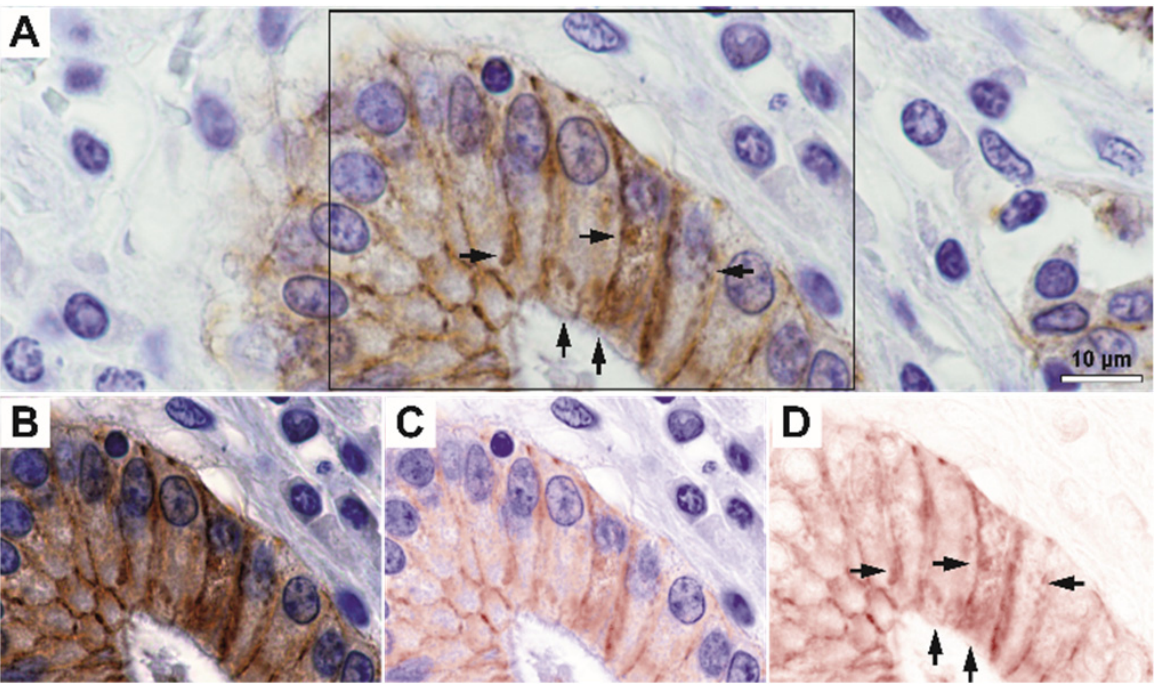
Figure 2. Exemplary image of control gastric glandular epithelium stained for E-cadherin. ( A ) RGB image and ( B – D ) unmixed individual and merged images showing membrane and intracytoplasmic staining (arrows). The rectangle in Figure ( A ) represents the selection illustrated in images ( B – D ). Scale bar for images ( A – D ), 10 µ m.